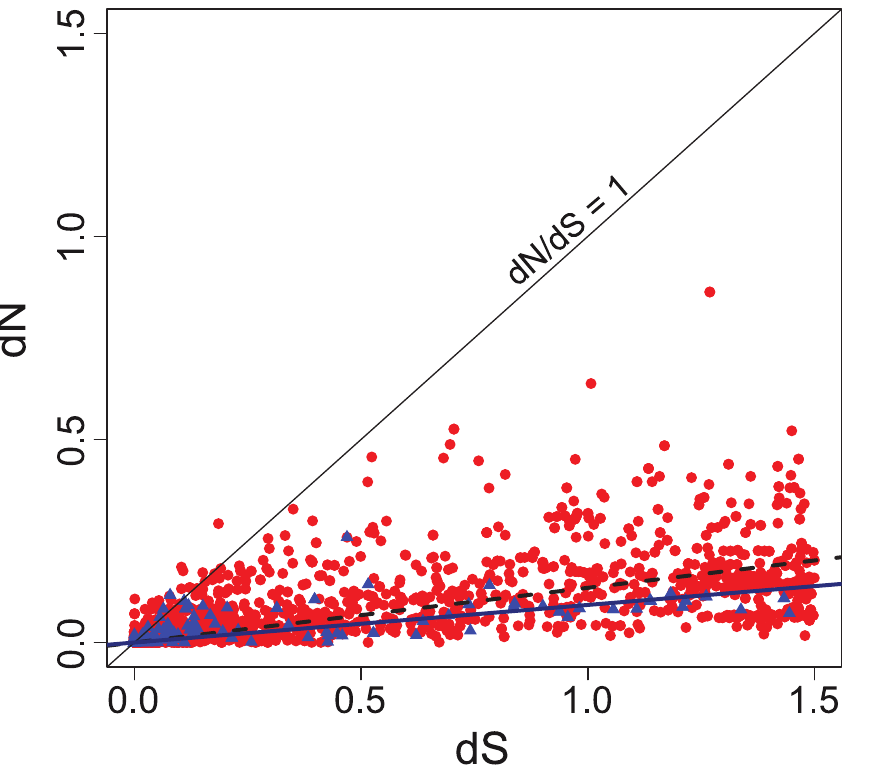
Figure 5. Evolutionary rates differ between paralogs and xenologs. Non-synonymous (dN) and synonymous (dS) substitution rates in paralogs (blue; dashed linear fit) and xenologs (red; solid linear fit) in all clades computed using Codeml from PAML [76] (model=1, fix_omega=0).